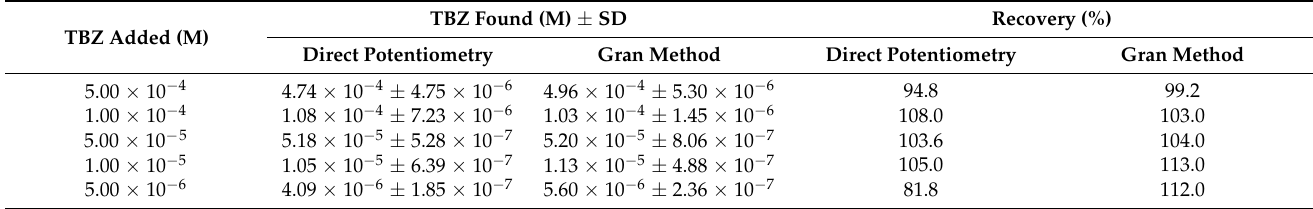
Table 4. Results of the TBZ determination in aqueous samples obtained using direct potentiometry and the Gran method 1